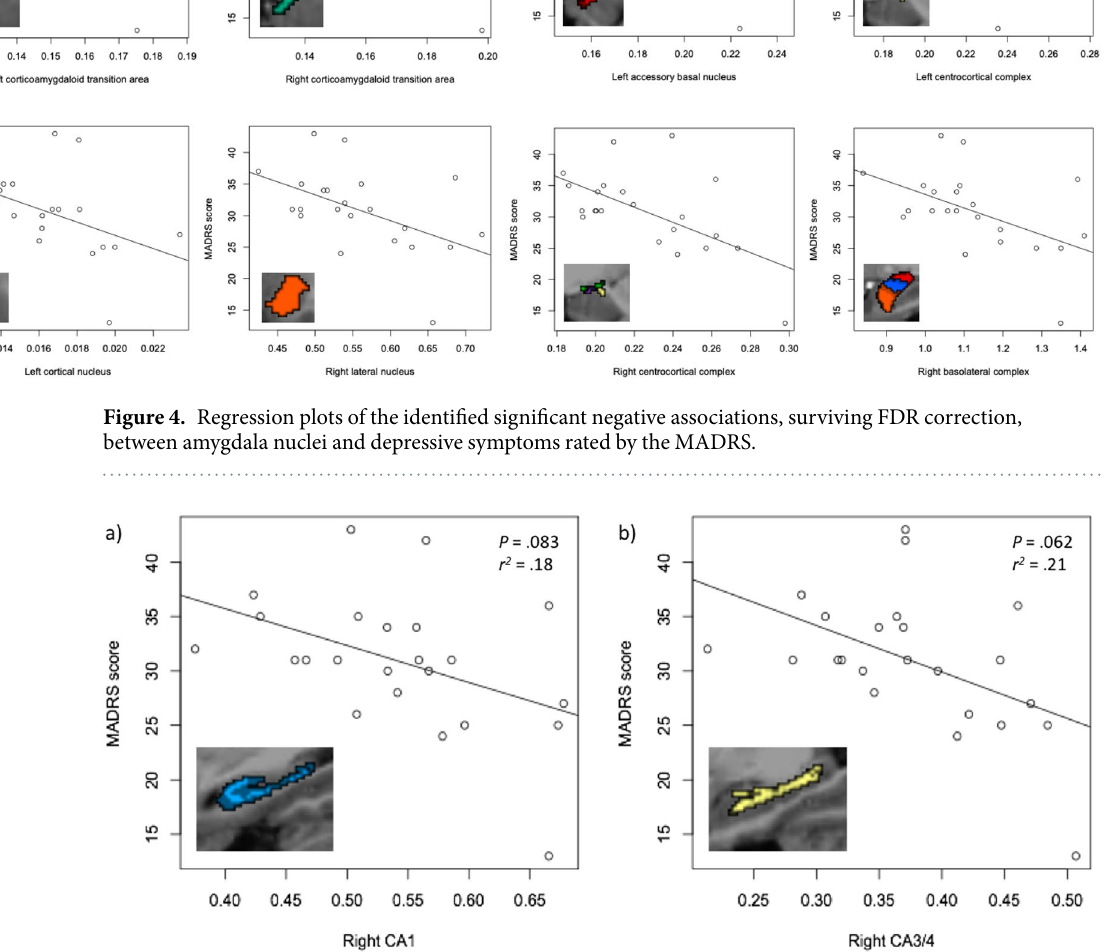
subfields, amygdala nuclei or whole structures with stringent control for the known effects of age, gender and antidepressant treatment. Our present high-field imaging analysis of the amygdala shows that in the left hemisphere, the centrocor- tical complex (driven mainly by the cortical nucleus), the accessory basal nucleus and the corticoamygdaloid transition area are significantly associated with MDD severity. In the right hemisphere, all regions were signifi- cantly related to MDD symptomatology, although some nuclei only exhibited correlations when grouped into the basolateral and centrocortical complexes. Moreover, orthogonalization of the data showed that although many subregions of the amygdalo-hippocampal complex are cross-correlated, component loadings did not tally with volumes of significant association with MADRS score. This indicates that the present results do not reflect a general sensitivity of the overall complex to depression severity, but show changes of individual nuclei that are to some degree independent. The amygdala sub-complexes and nuclei are considered anatomically, functionally, and connectively sepa- rate 35,48,49 , and previous studies of mood disorders and stress in animal models show differential GABAergic system modulatory responses of the amygdala nuclei to specific mood disorder-implicated behaviors, linking the basolateral complex to fear extinction, the medial nuclei to sociability and the central nuclei to anxiety and aggression 50–54 . Nevertheless, in rat models of stress, markers of neuronal inhibition in the amygdala were reduced uniformly across nuclei compared to controls. Evidence from animal models also shows that multiple amygdala nuclei exhibit associations between grey matter volume and depressive phenotypes 55 . The results reported here